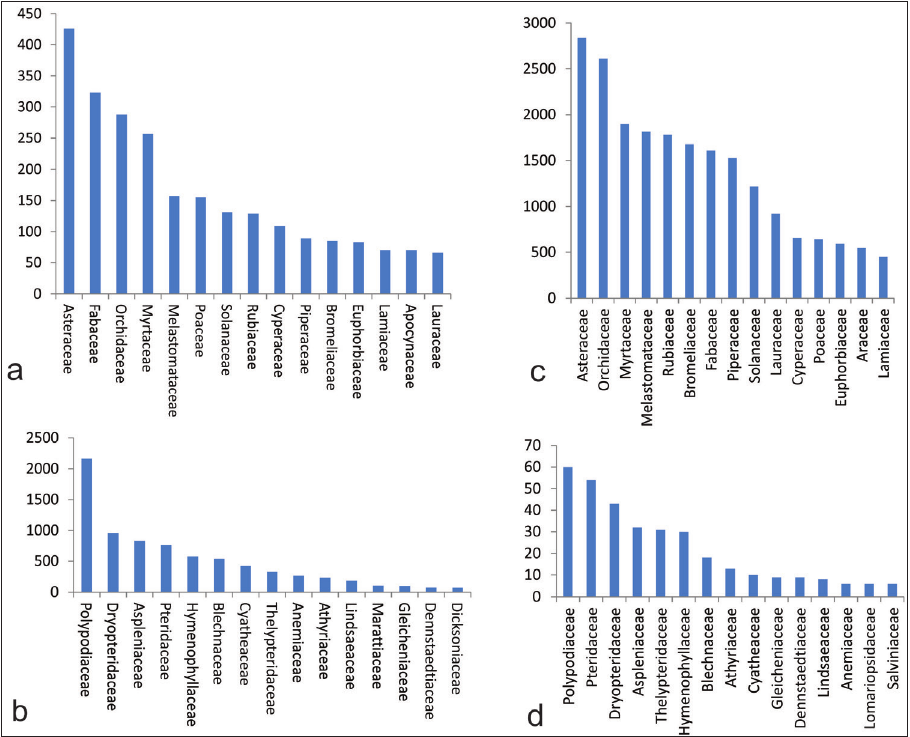
Figure 2. Number of specimens of the main families of angiosperms ( a ), ferns and lycophytes ( b ) in FURB collection. Number of specimens of angiosperms ( c ), ferns and lycophytes ( d